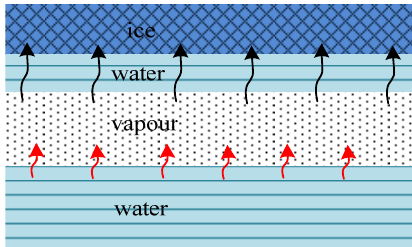
Figure 10. Energy balance of moisture mass transfer during freezing in soils.